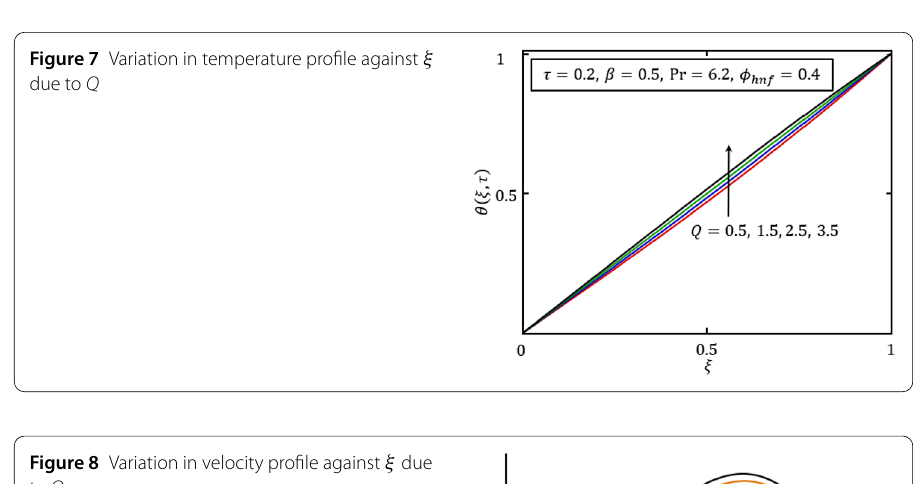
Figure 8 Variation in velocity profile against ξ due to